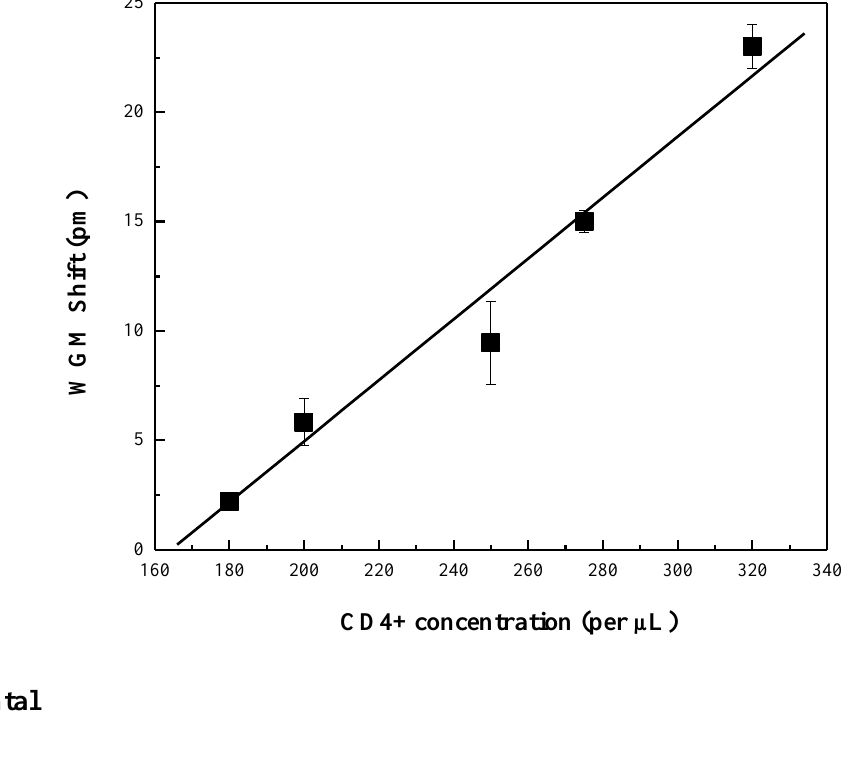
Figure 5. Spectral shift recorded for concentrations of CD4+ T-Lymphocyte cell lysis. Error bars are based on standard deviation obtained from 5